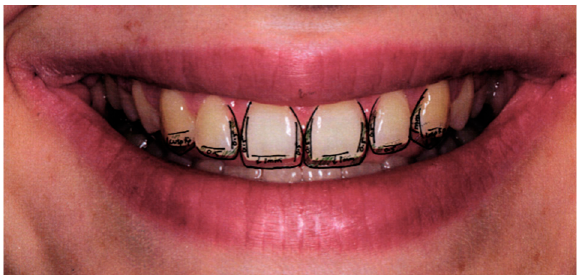
Figure 6. Case 2 smile designing and communication with the orthodontist.